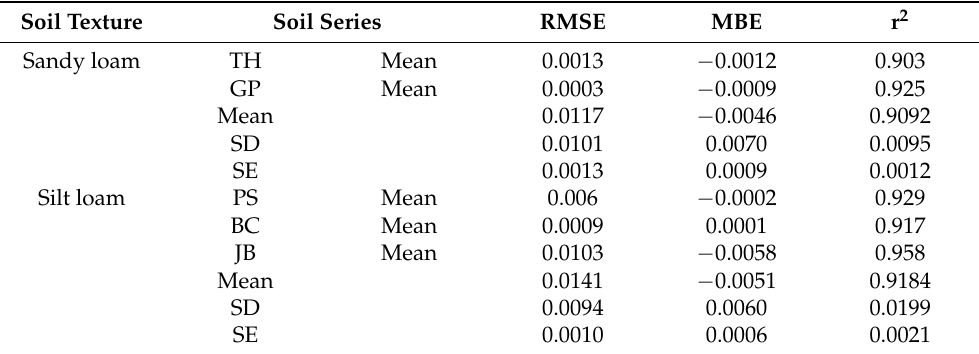
Table 5. Root mean square error (RMSE), mean bias error (MBE), and coefficient of determination (r 2 ) of median, minimum, and maximum water contents measured at matric potentials ranging from 0 to − 1500